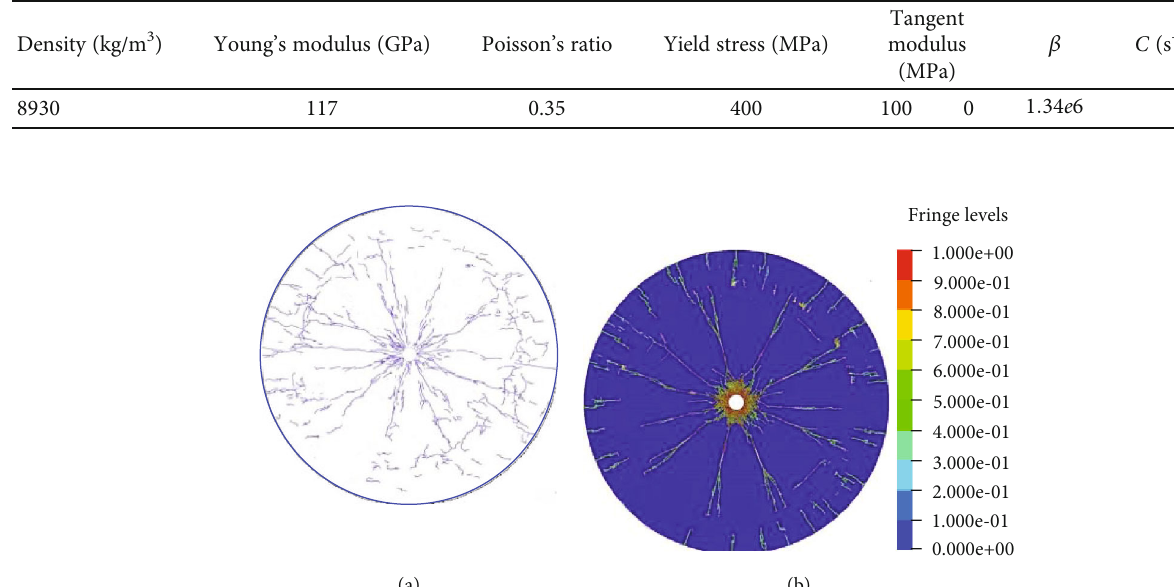
Table 4: Parameters for copper.